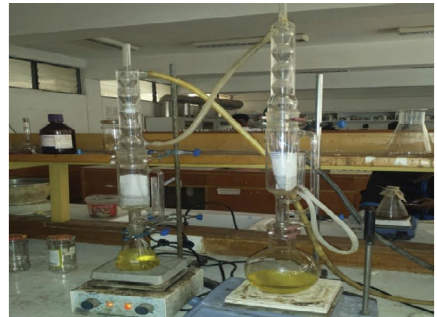
Figure 1: Soxhlet extraction of fat.